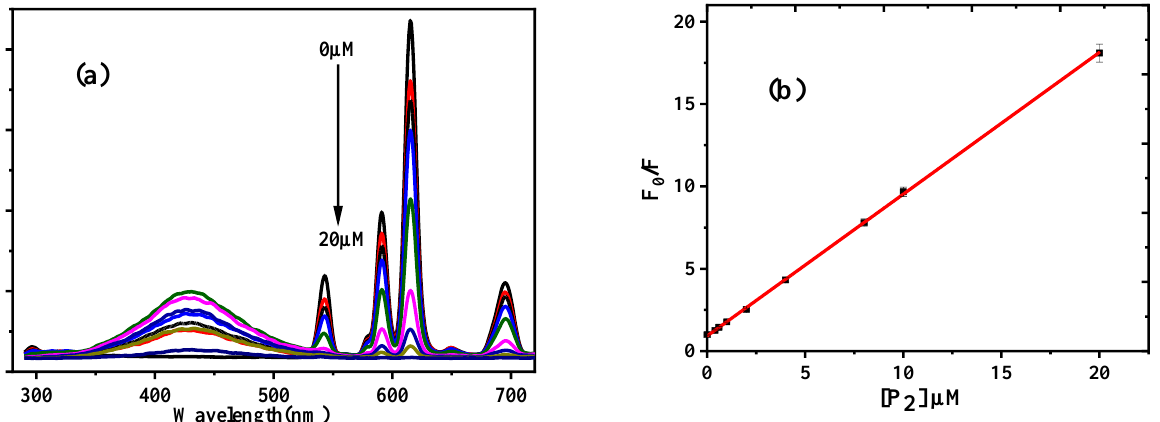
Figure 6. The ( a ) luminescence spectra and ( b ) calibration plot of the 2.5 × 10 − 5 mol · L − 1 of Eu (III)–complex with different concentrations of chlorfenvinphos (p2) (0, 0.4, 0.6, 1, 2, 4, 8, 10, and 20 µ M) in methanol, at λ ex = 268 nm and room temperature.